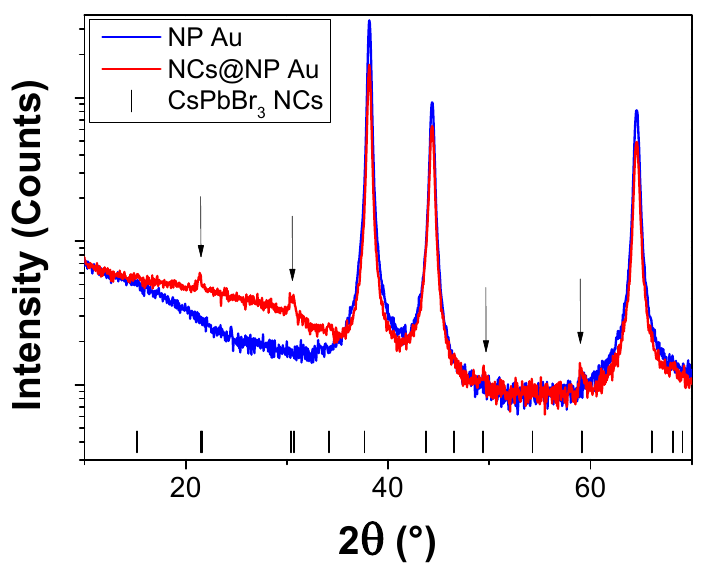
Figure 7 . XRD pattern of the sample of pure NP Au (blue) and the NCs@NP Au heterostructure (red). The vertical bar individuates the main peaks of pure CsPbBr 3 NCs.